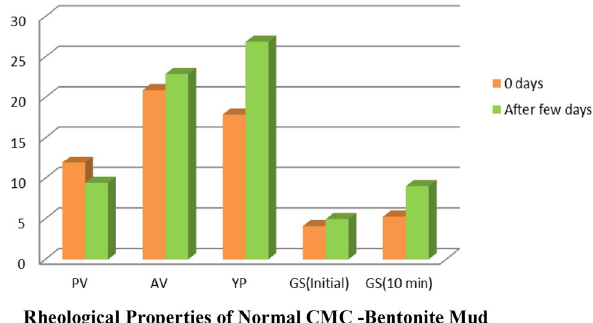
Fig. 29 Rheological properties of non-optimized PHPA–bentonite mud in accordance with